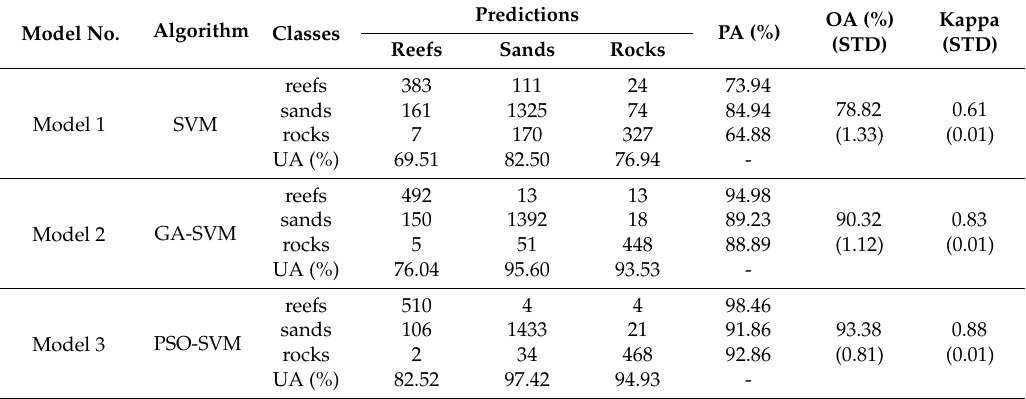
Table 4. Evaluation of classification results based on MBES backscatter features. Model No.